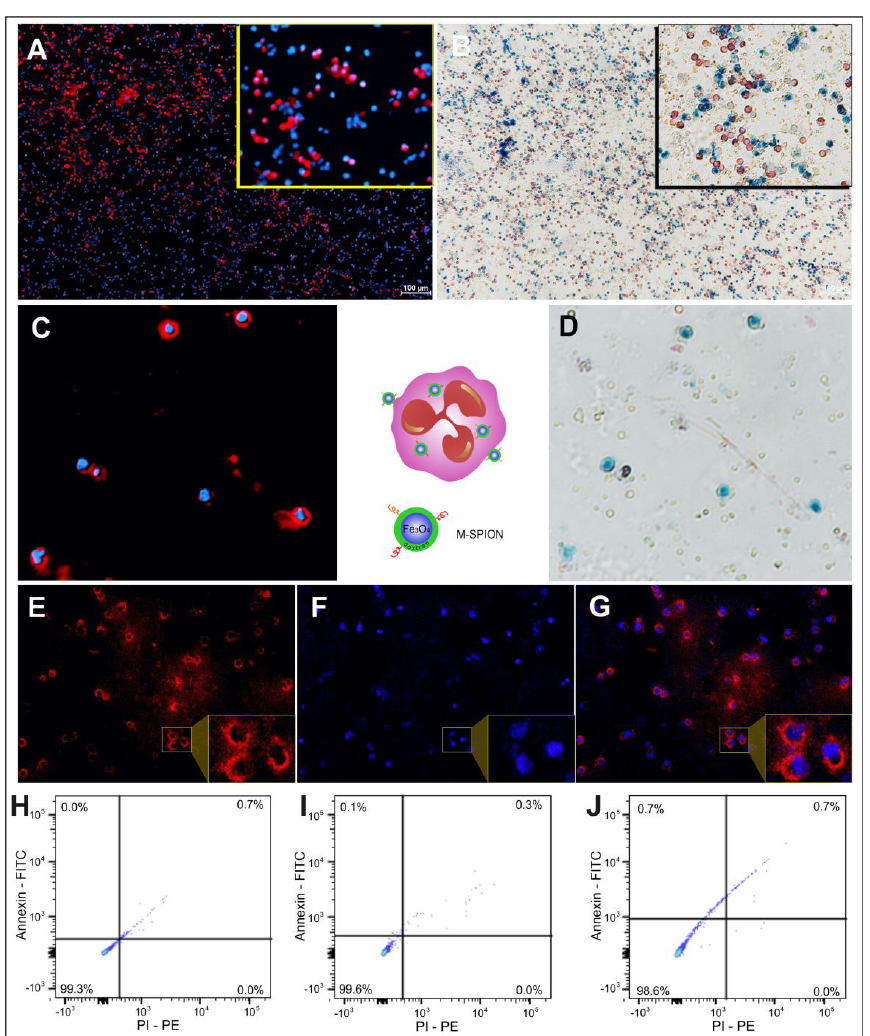
Figure 4. Fluorescence and brightfield microscopy and the viability of granulocytes labeled with M-SPIONs. ( A ) Fluorescence microscopy image of granulocytes labeled with M-SPIONs (4x). ( B ) Brightfield microscopy image of the granulocytes labeled with M-SPIONs and stained with Nuclear Fast Red and Prussian blue (4x) ( C , D ) Images corresponding to the same field of view of the granulocytes labeled with M-SPIONs by fluorescence and brightfield microscopy (4x). ( E ) Rhodamine imaged by fluorescence microscopy. ( F ) The corresponding image of granulocyte nuclear staining by DAPI. ( G ) Merged images of rhodamine/DAPI. The inset images ( A,B , E – G ) correspond to the amplified view of a selected area.( H – J ) V iability was evaluated with M-SPION concentrations of 10, 30 and 50 μg Fe/mL respectively , with double negativity for Annexin-FITC and PI-PE. 2.5. Quantification of M-SPIONs Internalized into Granulocytes by MRI, ICP-MS and NIRF MRI, ICP-MS, and NIRF were used to quantify the iron mass internalized into granulocytes after M-SPION incubation at concentrations of 10, 30 and 50 µg Fe/mL. The quantification results of the iron mass per cell and the number of nanoparticles per granulocyte are shown in Table 7 and Figure